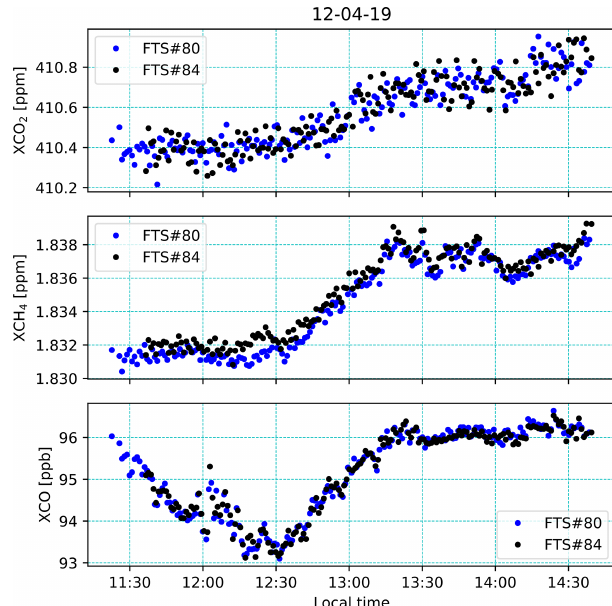
Figure 2. Side-by-side measurements during the campaign but only with instruments FTS#80 and